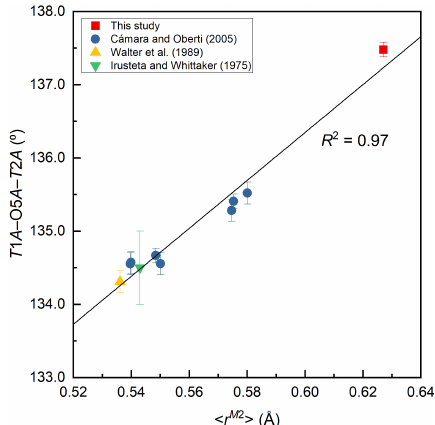
Figure 6. Variation of T 1 A –O5– T 2 B angle ( ◦ ) against the mean ionic radius of the constituent cations at M 2, <r M 2 >